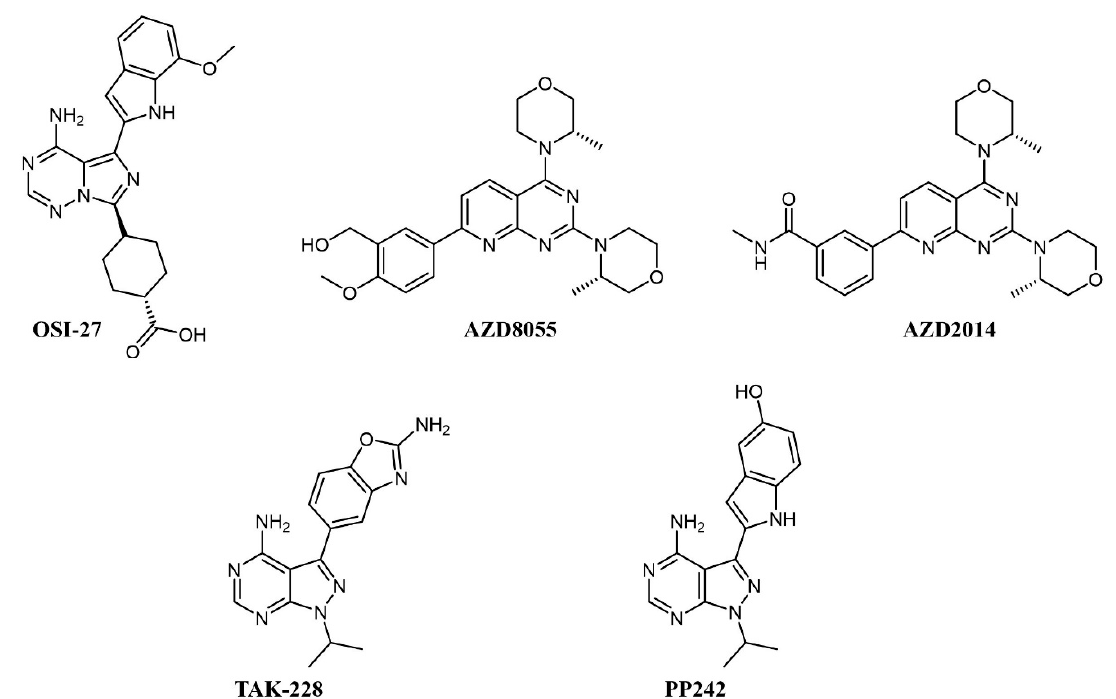
Figure 2. Chemical structure of dual mTOR complex 1 (mTORC1)/mTORC2 inhibitors used for acute myeloid leukemia (AML) treatment.